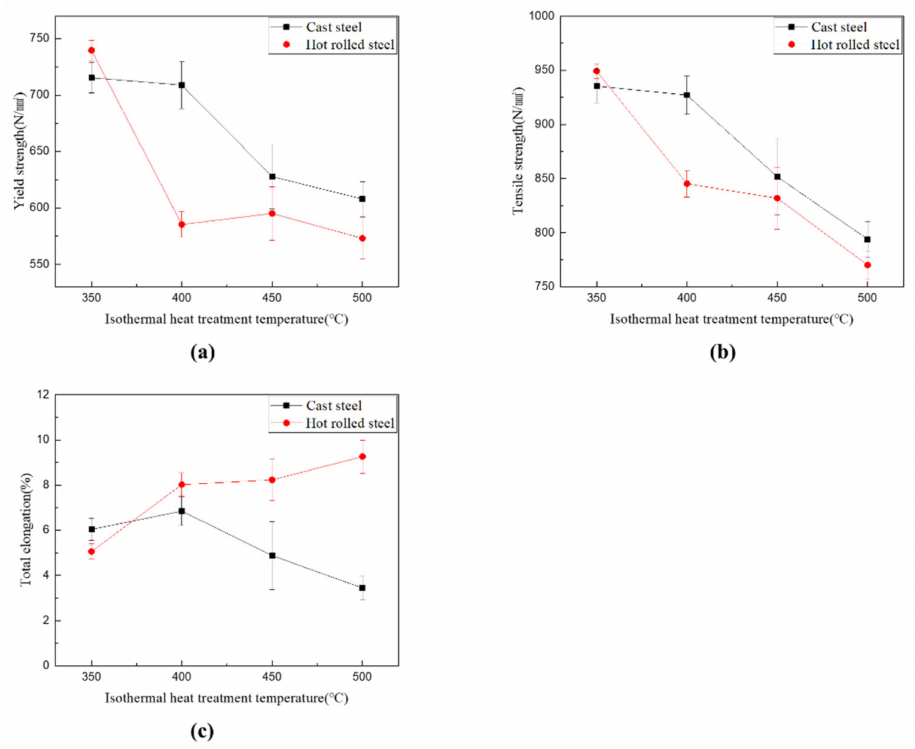
Figure 12. Variation in the ( a ) Yield strength, ( b ) Tensile strength and ( c ) elongation of medium-carbon low-alloy steel with the isothermal heat-treatment